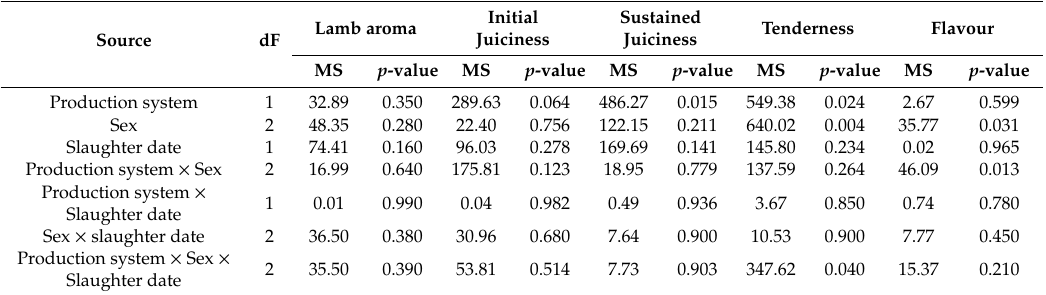
Table 2. Analysis of variance (ANOVA) for the attributes: aroma; initial juiciness; sustained juiciness; tenderness; and flavour for Dorper lambs (rams, ewes, castrates) reared either under free-range conditions or in a feedlot system.